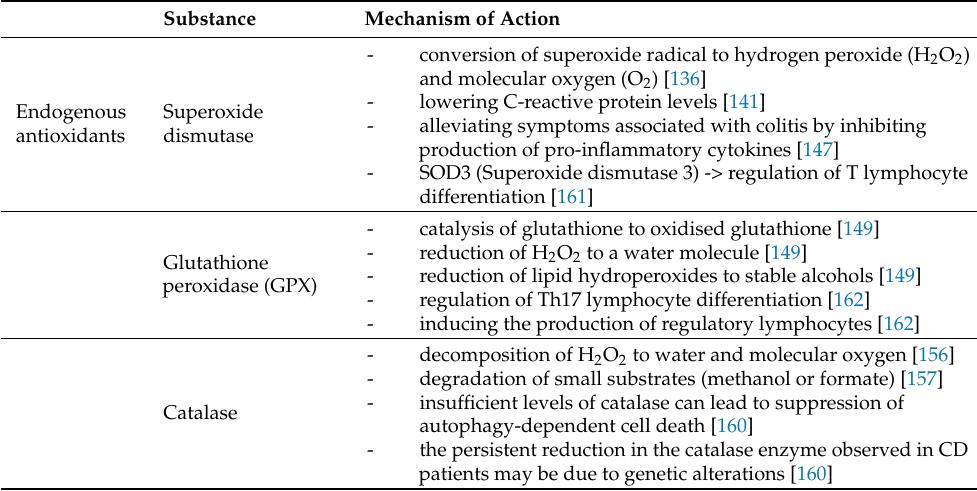
Table 1. Summarising the mechanism of action of